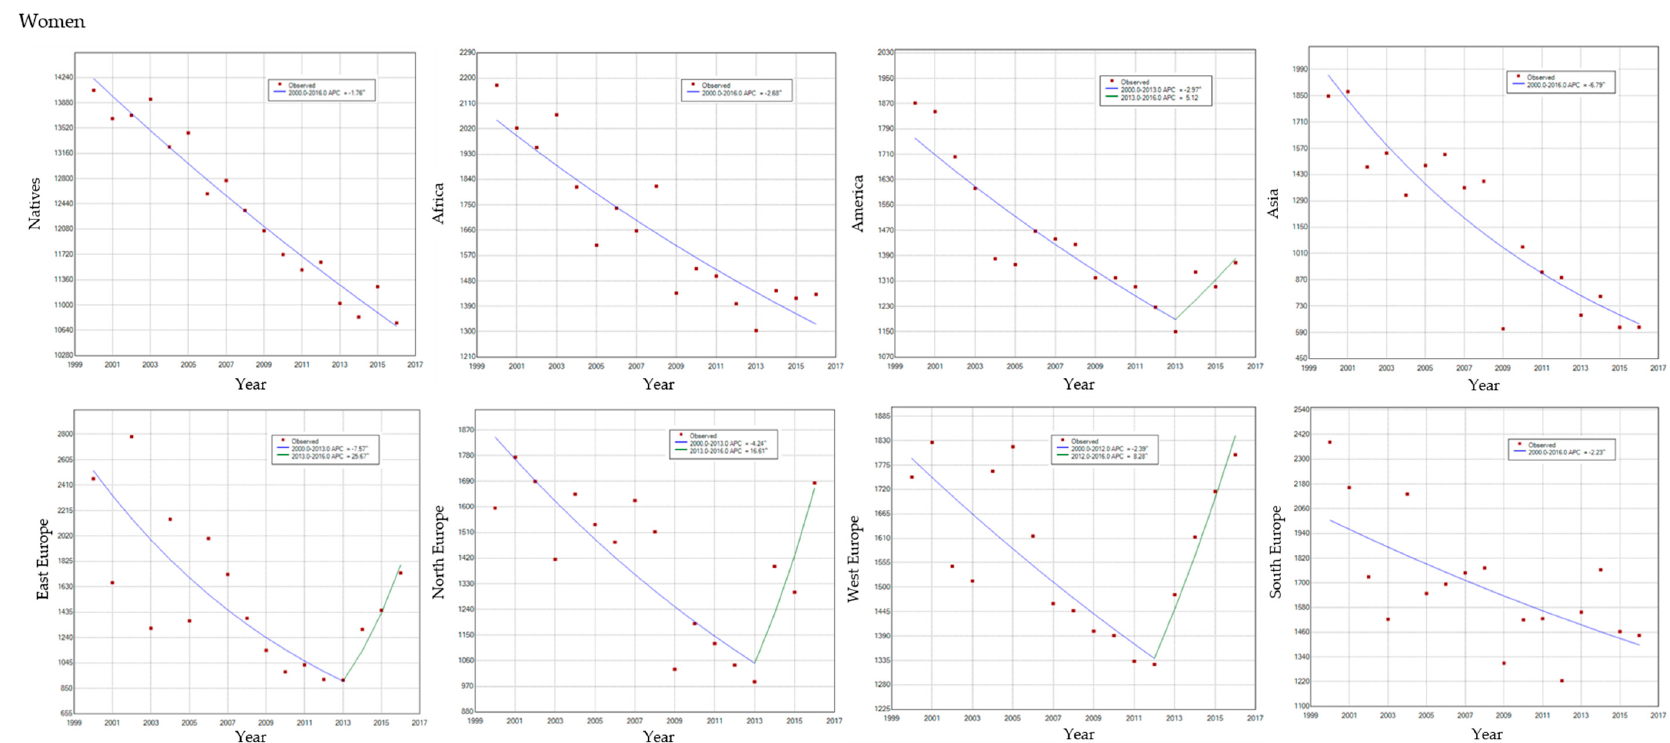
Figure 4. Age-standardized rates of cancer mortality (ASR), Joinpoint, and trends in immigrants by region of birth and natives in both sexes, for the period 2000– 2016.